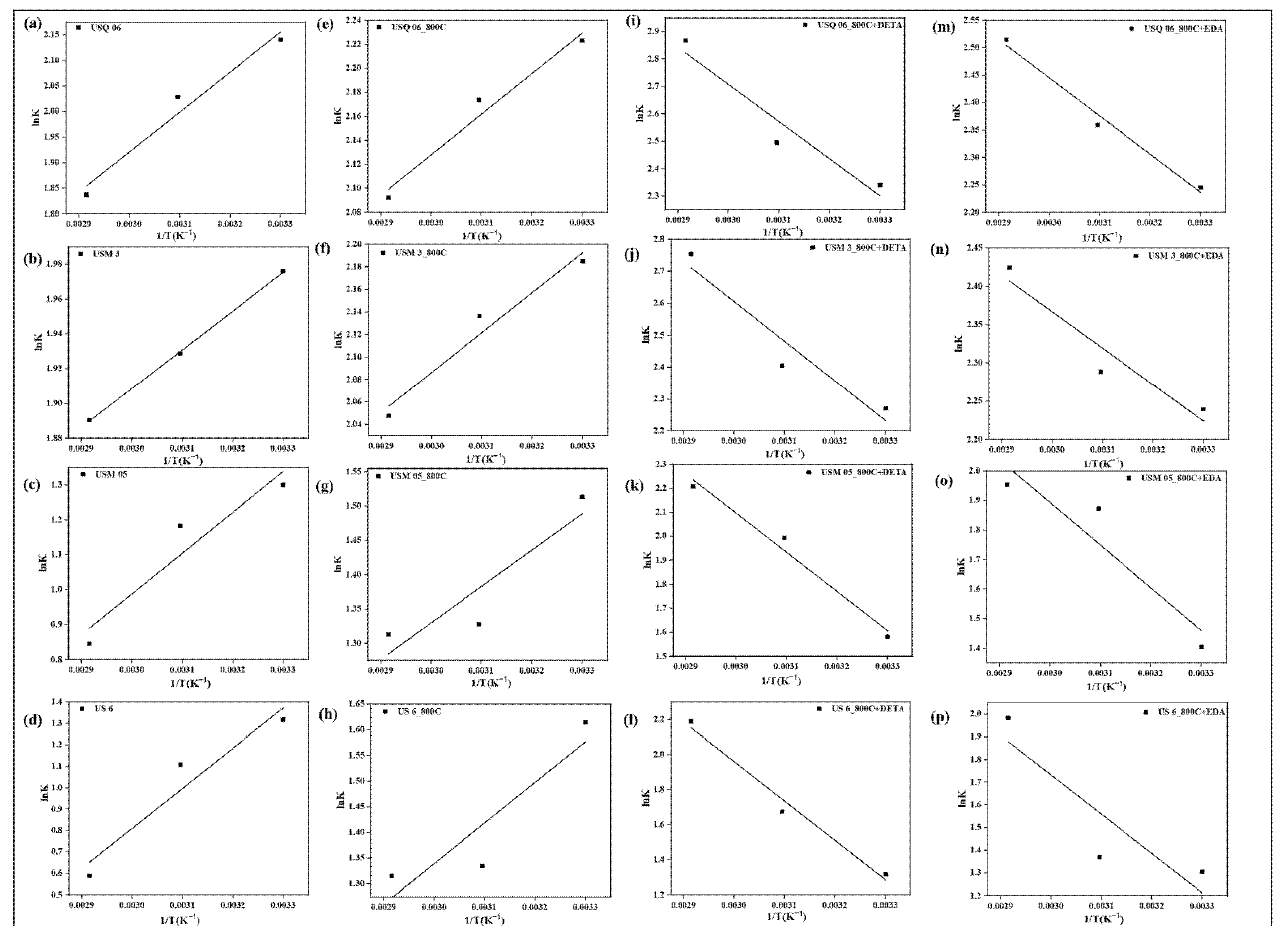
Figure 18. Van ‘t Hoff plots based on the CO 2 sorbed on Raw shale ( a – d ), Spent shale ( e – h ), DETA- modified spent shale ( i – l ), and EDA-modified spent shale ( m – p